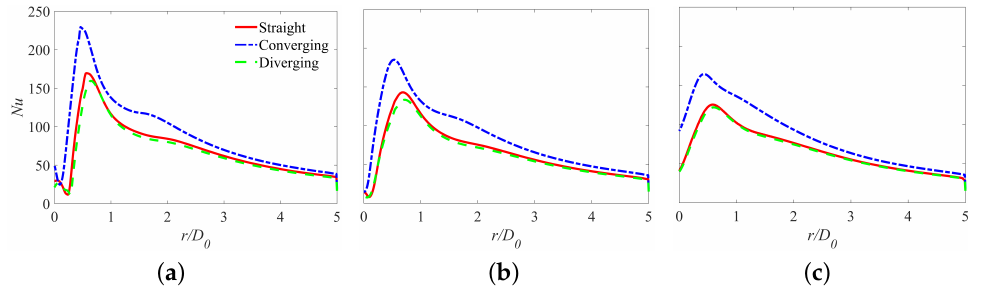
Figure 20. Radial Nusselt number Nu on the target surface at ( a ) H = 0.5, ( b ) H = 2, and ( c ) H =